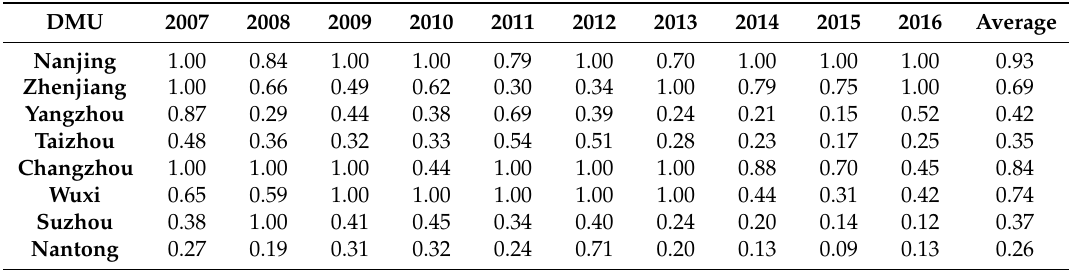
Table 3. Results of EGE for the Yangtze River urban agglomeration from 2007 to 2016. DMU